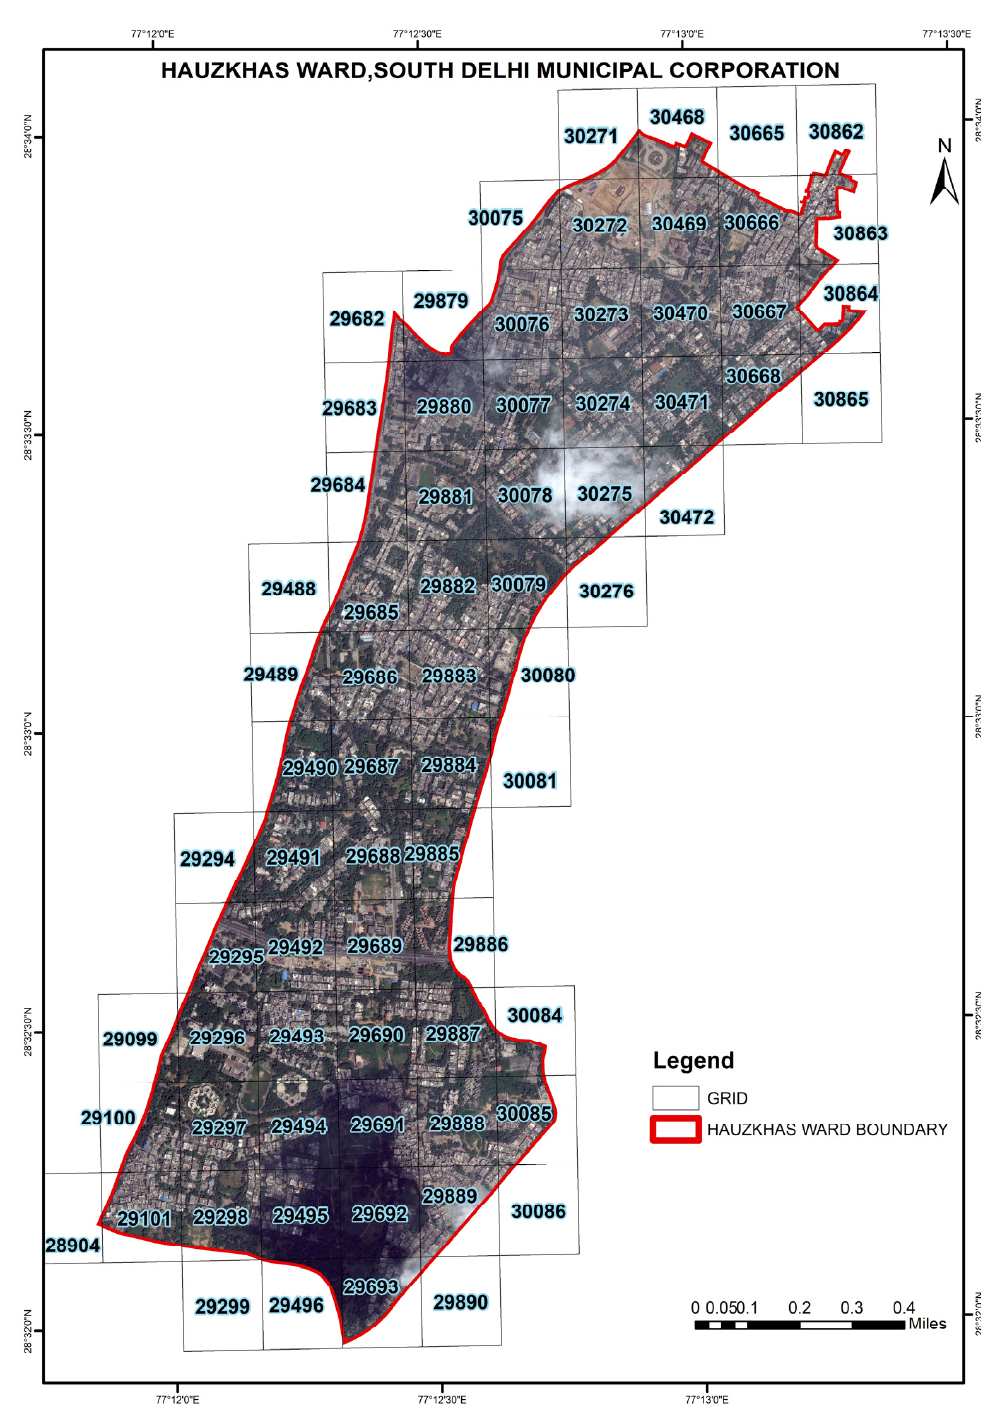
Figure 4. Geodatabase structure of the Hauz Khas ward (II).